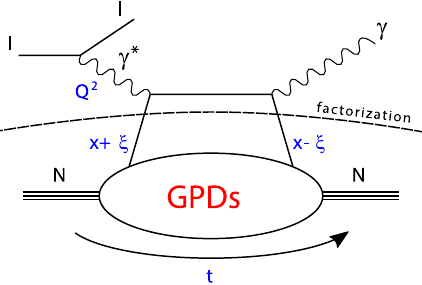
Fig. 1 Partonic interpretation of the DVCS